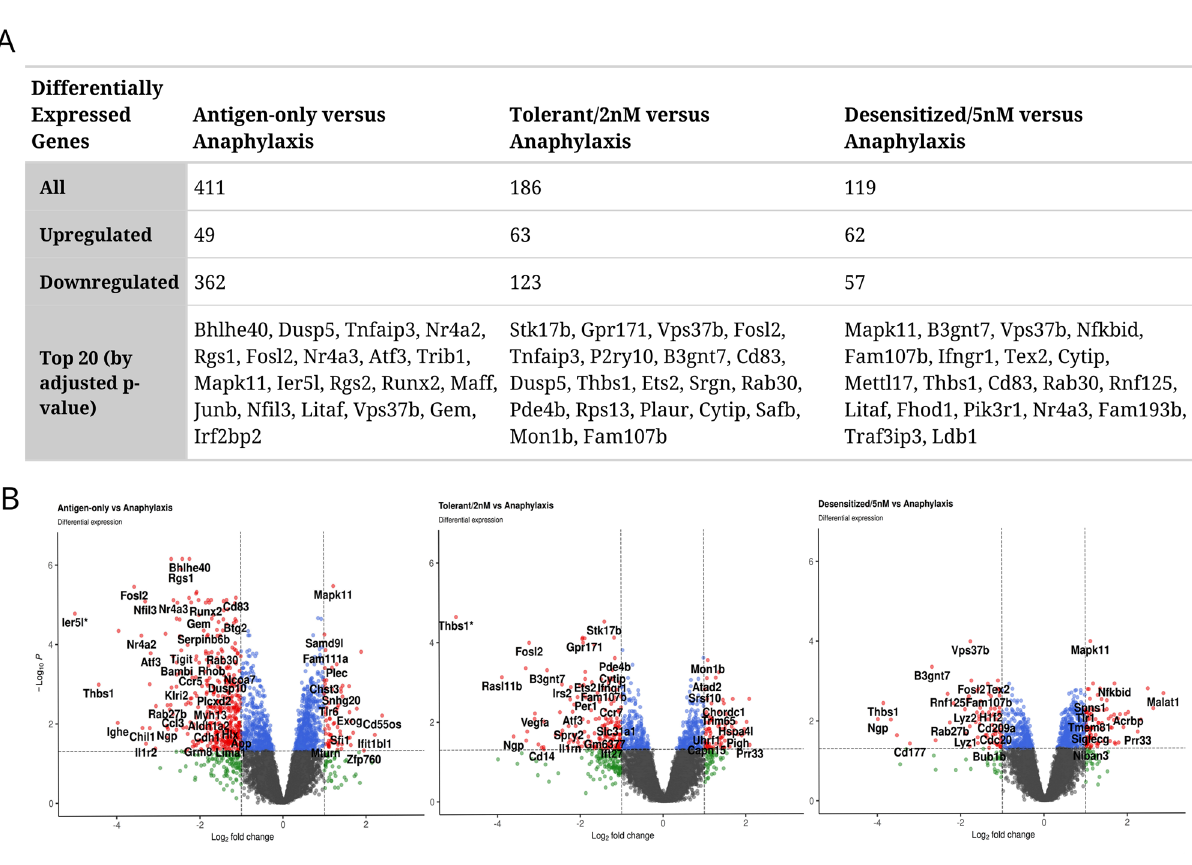
Figure 3. Global changes in gene expression between groups. ( A ) Table summarizing the number of differentially expressed genes (DEGs) in the different groups, Antigen-only, Tolerant/2 nm and Desensitized/5 nm, compared to the Anaphylaxis animal group ( P -value < 0.05, abs(log2 fold change) > 1). ( B ) Volcano plots for each comparison, adjusted P -value vs. fold change for the different groups vs. Anaphylaxis. *DEGs with absolute Log2FC >